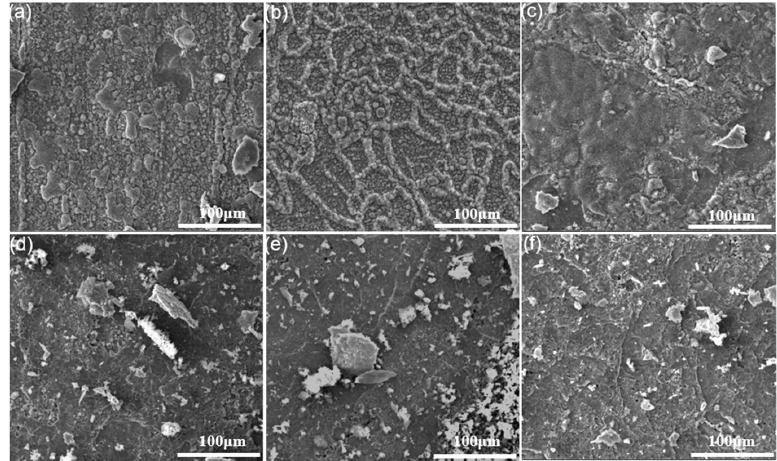
Figure 8. Surface morphology of alloys after oxidation at 1000 °C for 4 and 100 h: ( a,d ) 0 ° sample; ( b,e ) 55 ° sample; ( c,f ) 90 ° sample.